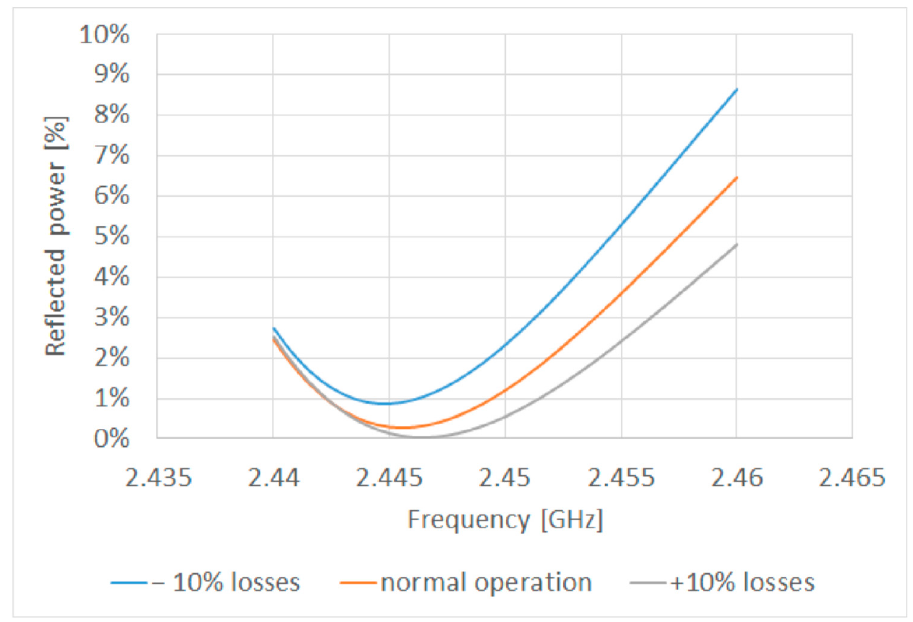
Figure 5. Reflected power (|S11| 2 ) in the optimized geometry condition as a function of possible small variations in plasma equivalent permittivity.